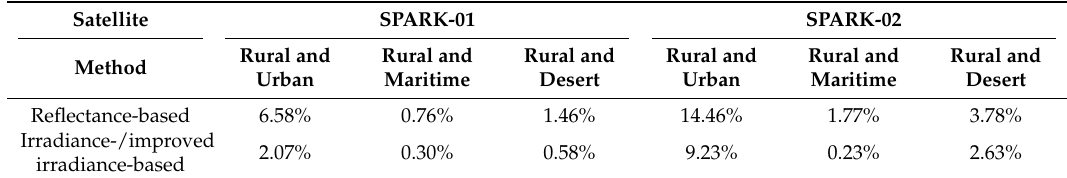
Figure 23. Relative differences in radiance using different aerosol types for the SPARK-01 calibration for 7 March 2017 using ( a ) the reflectance-based method and ( b ) the irradiance-based method.